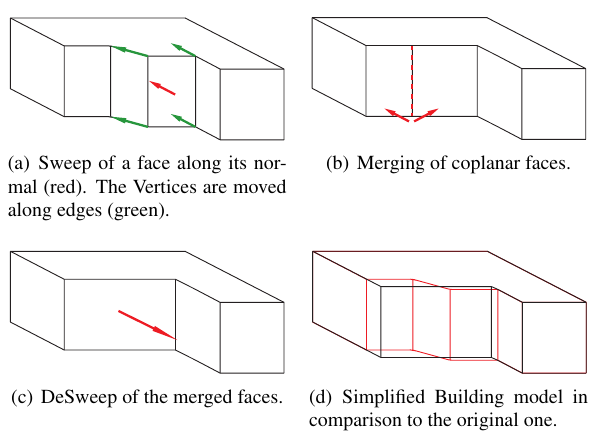
Figure 1. Sweep operation applied to a simple building